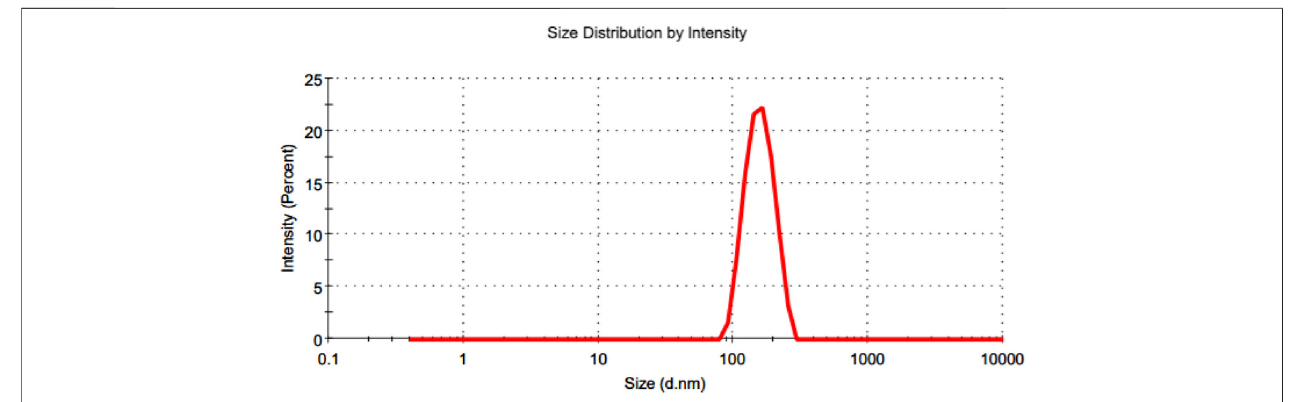
FIGURE 2 | A typical representation of particle size distribution pro fi le of the fabricated PBCA-NPs (i.e., formulationT0P0).